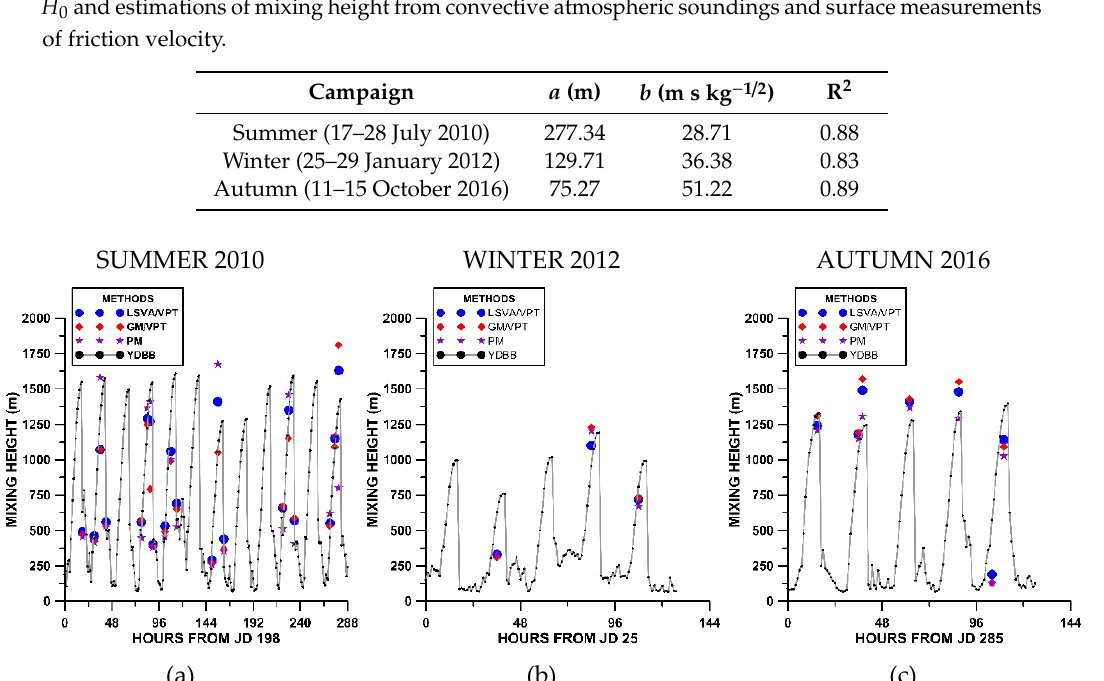
Figure 15. Application of the Yi, Davis, Berger, and Bakwin (YDBB) model described by Equation (16) to estimate the hourly growth of the mixing height throughout the periods of ( a )17–28 July 2010, ( b ) 25–29 January 2012, and ( c ) 11–15 October 2016. We also presented the mixing height estimations with the LSVA / VPT, GM / VPT, and PM methods. The abscissae represent the number of hours past from the start (expressed by the Julian day) of the RS campaign.